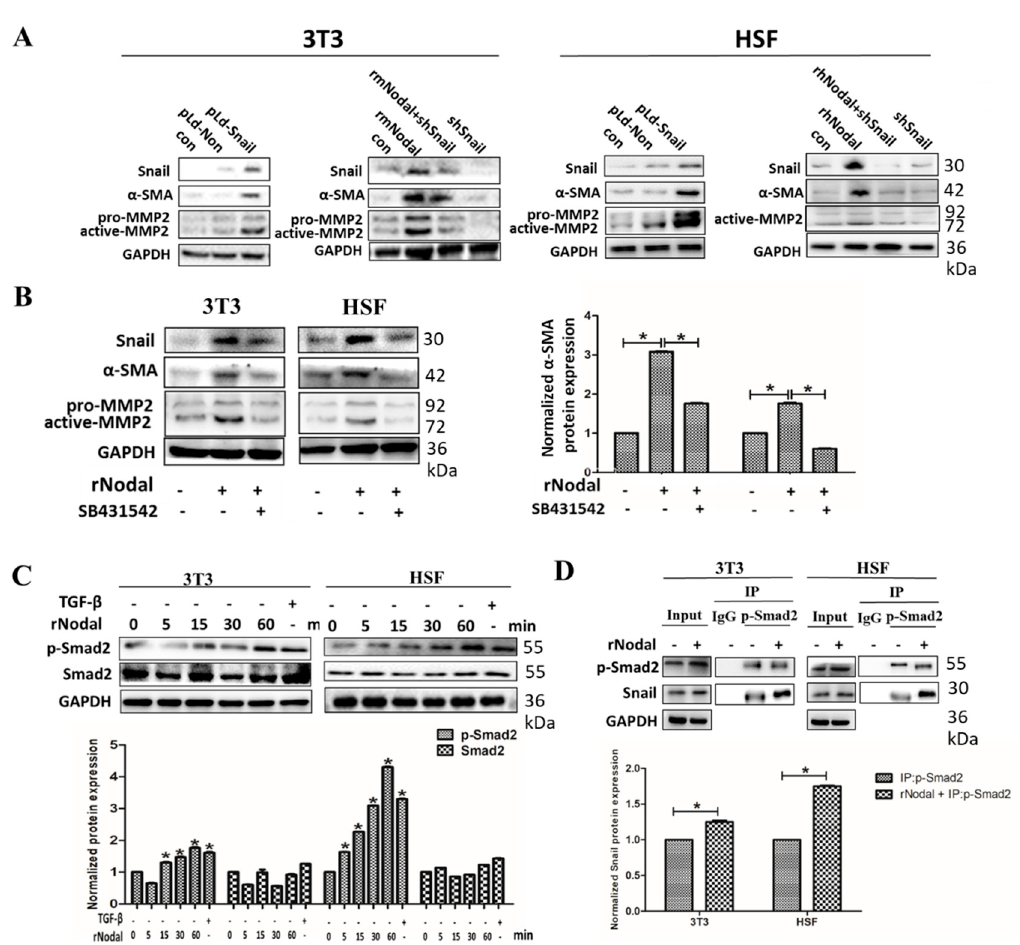
Figure 3. Snail contributes to fibroblasts differentiation induced by Nodal via TGF- β signaling pathways. ( A ) 3T3 and HSF cells were transfected with pLd-Snail or treated with Nodal protein in the absence or presence of the shSnail plasmid, and the expression of Snail, α -SMA, and MMP2 was determined by western blot. ( B ) 3T3 and HSF were pretreated with or without SB431542 (20 μ M) for 2 h and then treated with Nodal protein (600 ng/mL) for 48 h. The expression of Snail, α -SMA, and MMP2 was analyzed by western blot (left) and the expression of α -SMA was quantitatively analyzed (right). ( C ) 3T3 and HSF cells were treated with Nodal protein for 5 min, 15 min, 30 min, and 1 h or TGF- β for 30 min. The total and phosphorylation level of Smad2, a key protein of the TGF- β signaling pathway, was detected by western blot (up) and quantitatively analyzed (below). ( D ) 3T3 and HSF cells were treated with Nodal protein (600 ng / mL) for 12 h, and then Snail was immunoprecipitated from equal amounts of lysates and the associated Snail and phosphorylated-Smad2 was analyzed by western blot (up) and the expression of Snail was quantitatively analyzed (below). * p <